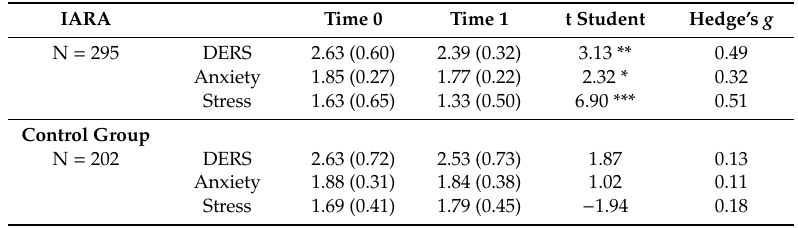
Table 3. Mean scores (SE) at the time points and e ff ect sizes for all the measured scales.